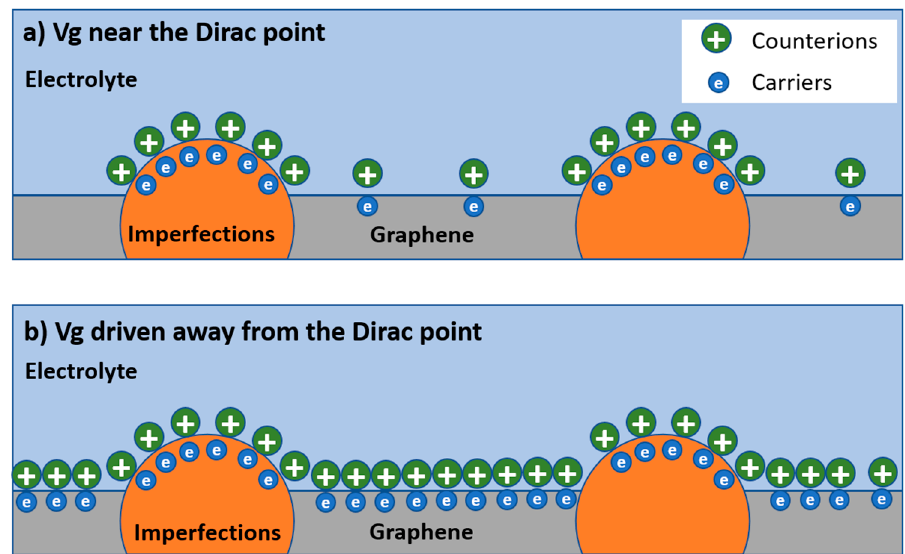
Figure 4. Schematic diagram showing the impact of the imperfection sites on the capacitance behavior of the electrolyte–graphene interface. The distribution of the charges at the electrolyte-graphene interface in the case of ( a ) V g near the Dirac point and ( b ) V g driven away from the Dirac point are demonstrated.